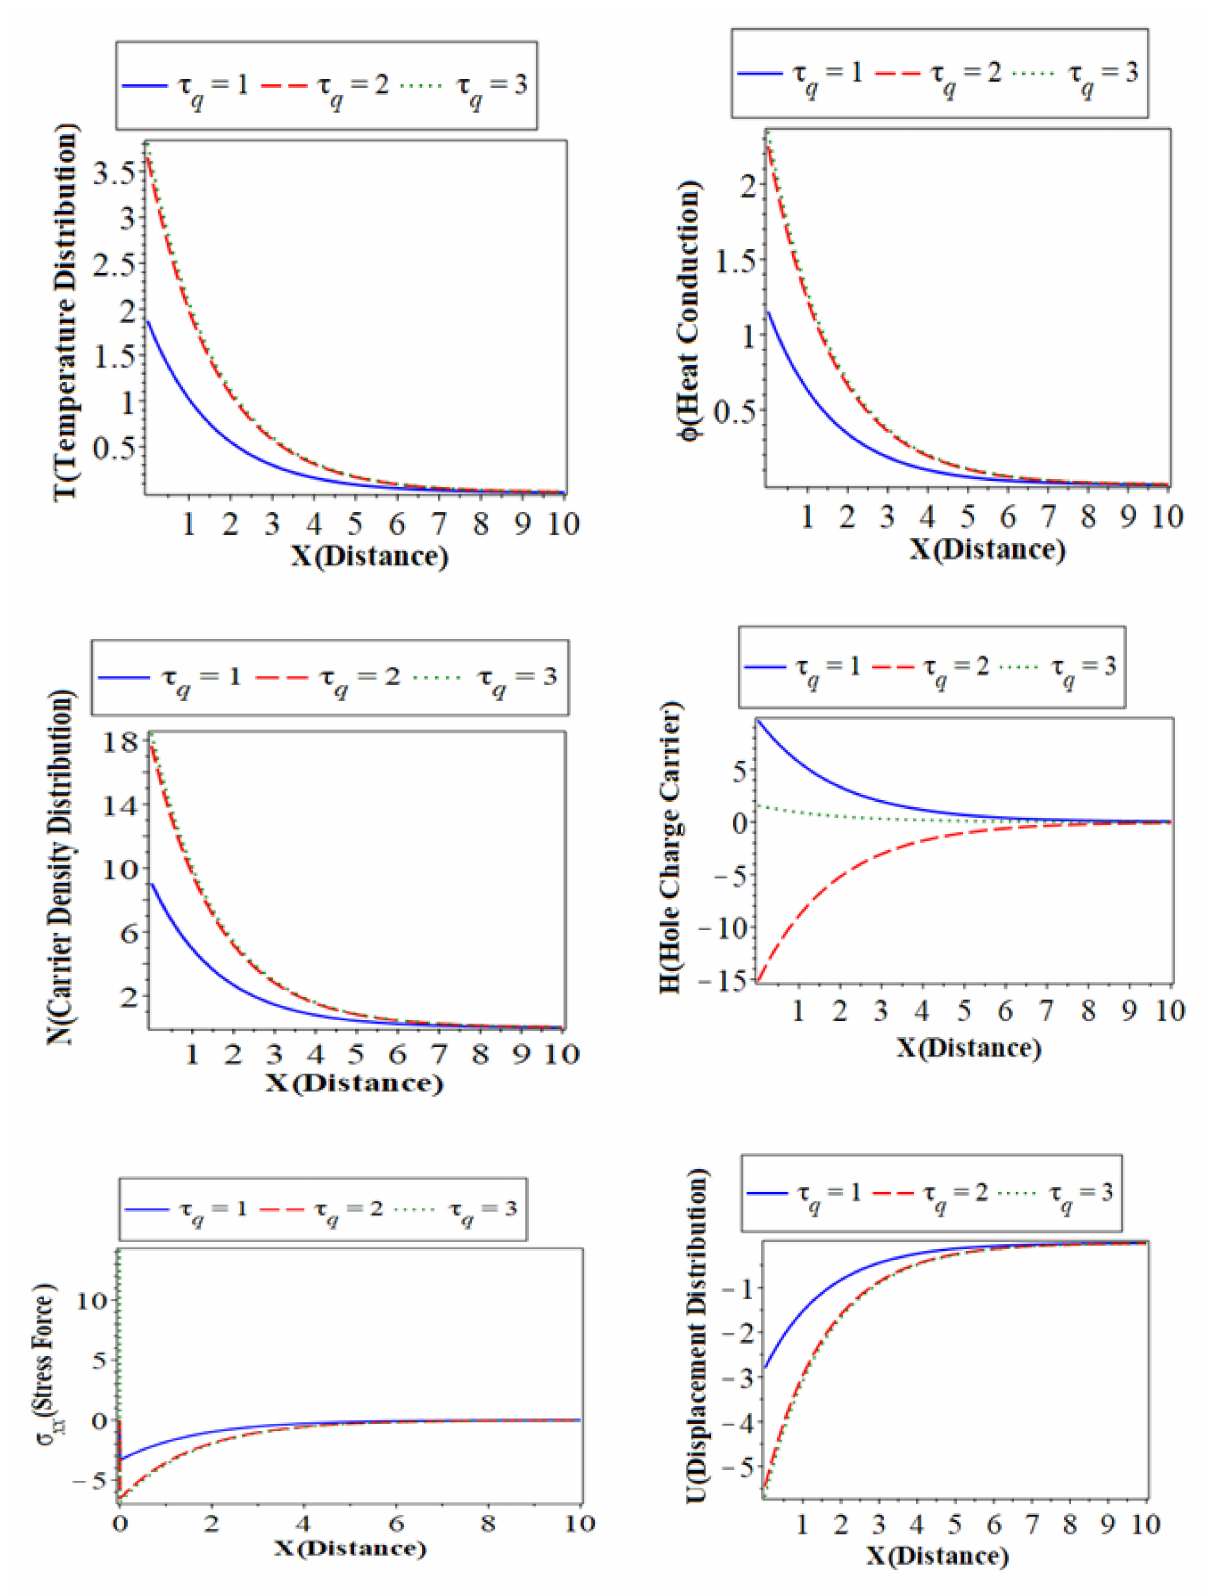
Figure 3. The variation of physical field distributions with distances at different values; the phase-lag of the heat flux τ q when ε 1 = 0.001 and τ θ =